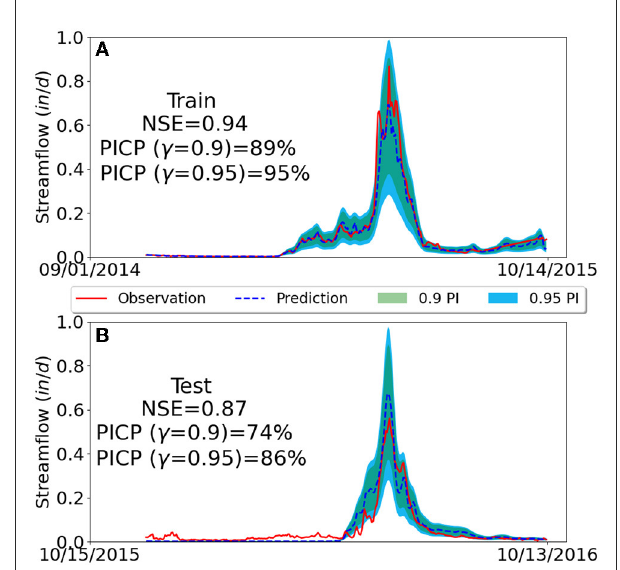
FIGURE6 Streamflow observations and predictions for different confidence levels ( γ ) in the Quigley catchment. The 95% PI ( γ =0.95) encloses 95% of the observations (PCIP=95%) and the 95% interval is wider than the 90% interval ( γ =0.9) showing accuracy of the PI3NN method. Subfigures (A, B) illustrate the results from training and test data sets,